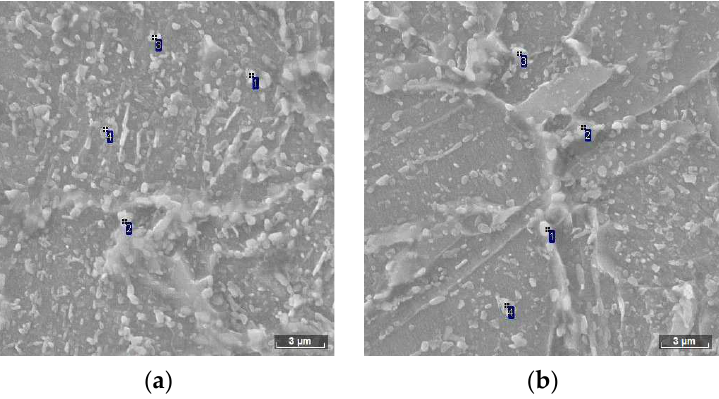
( b ) Figure 15. Comparison of LOM ( a ) and SEM ( b ) images of microstructure in segregations and base metal in CT. Also shown are areas for determining the chemical composition. Table 6. Chemical composition of the segregations and the base metal of the casing tube (CT) sam- ple, wt. %.